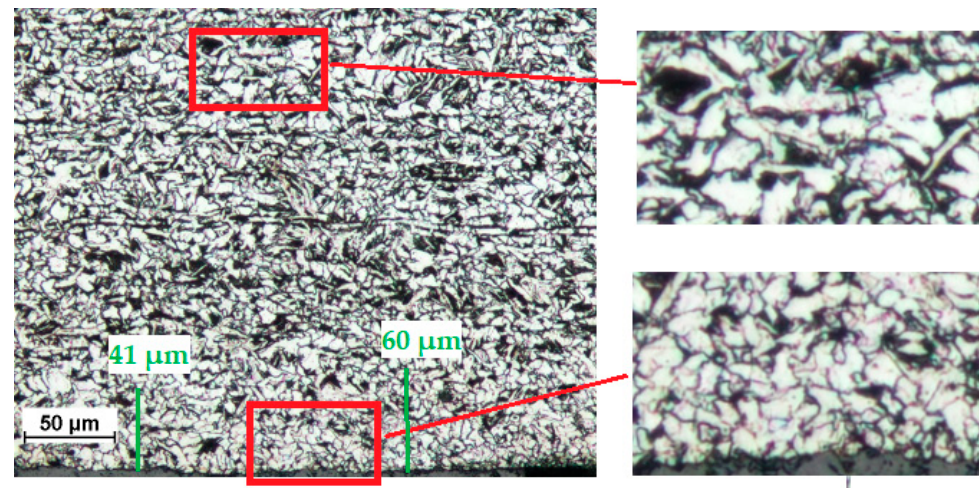
Figure 3. Microstructure of the uncut steel (the hot rolled steel).